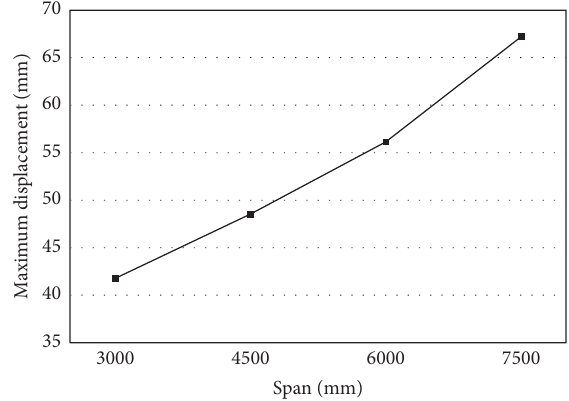
Figure 8: Effect of span length on